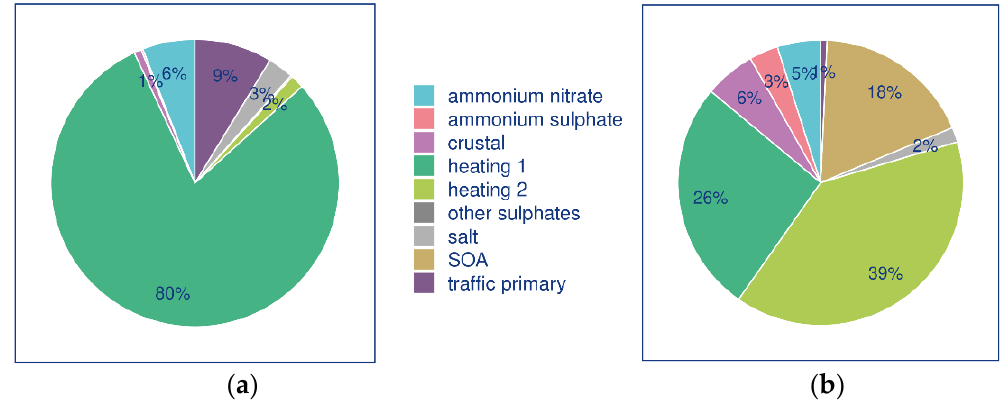
Figure 6. Overall relative factor contribution to benzo[ a ]pyrene ( a ) and arsenic ( b ) mass.